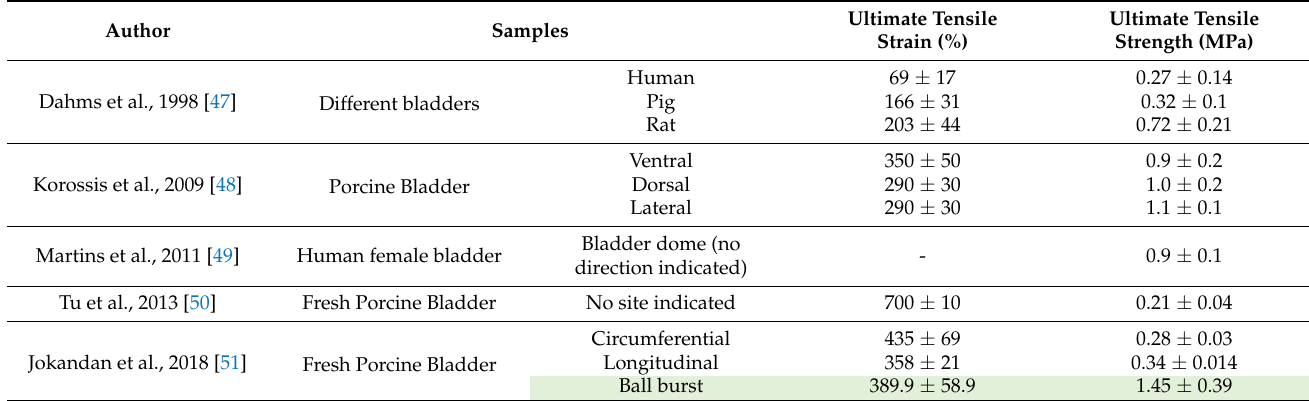
Figure 7. Shows the uniaxial test. Figure obtained with permission from [47]. ( a ) Shows suggested mechanism of sample preparation ( b ) Shows a schematic of uniaxial testing procedure. ( c ) Shows an image of pig bladder during uniaxial testing. Arrow indicates material failure. Table 1. Represents data extracted from the previously performed studies. All the results were obtained from uniaxial testing, besides the values marked in green. This data was obtained from a ball burst test and illustrates the differences between the tests as well as acts as a reference point for other data